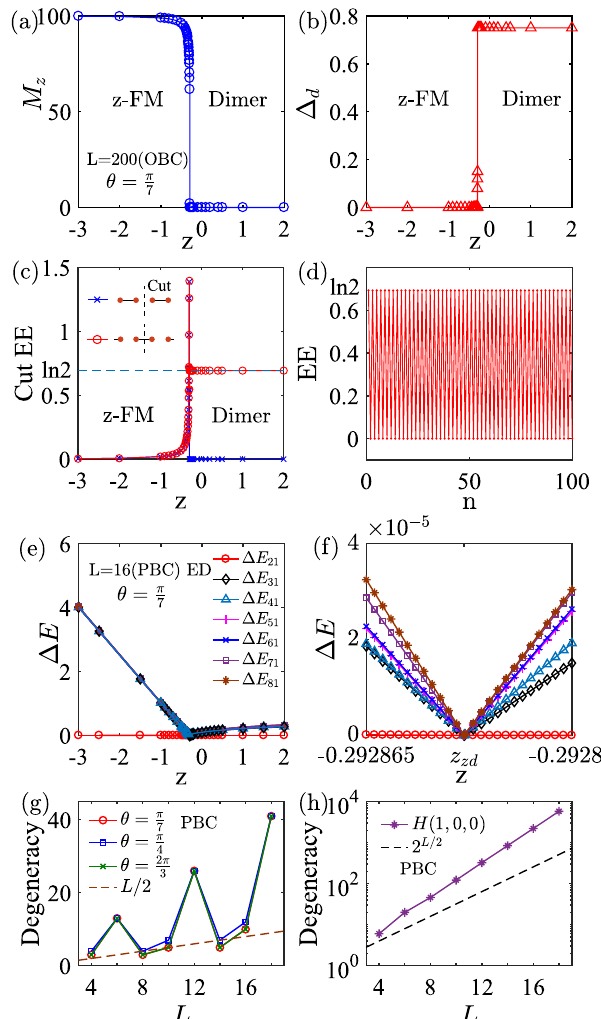
π/ 7 from density matrix renormalization Figure 4. ( a ) Dimer and ( b ) magnetization orders at θ = group (DMRG) method with open boundary condition (OBC). The numerical determined boundary is 0.29283 , while the exact boundary from Eq. (13) is z 0.29285 . ( c ) The cut EE (see definition in the z ex c = − = − π/ 7 . At the phase boundary, the EE exhibits a sharp peak. ( d ) A typical result inset) as a function of z at θ = for oscillating of EE due to singlet dimer state. ( e ) Excitation gaps δ E n 1 from z -FM to exact dimer phase. ( f ) The 16 from exact diagonalization (ED) enlarged excitation gaps near the critical point. Data are obtained for L = with PBC. ( g ) The degeneracy of the GSs at the phase boundary as a function of L and θ , which scales as O ( L / 2 ) . ( h ) The degeneracy of the GSs of H (1, 0, 0) with scaling of O ( 2 L / 2 )